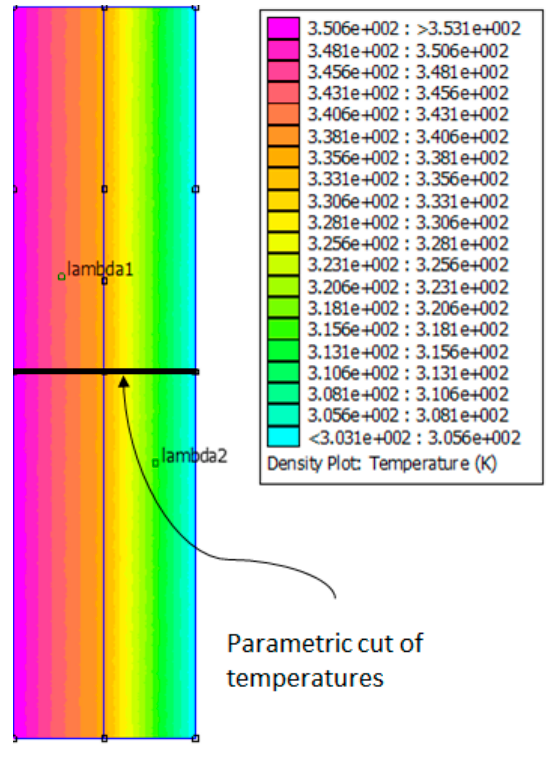
Figure 7. Temperatures of reference with FEMM and λ 1 = 50.0 Wm − 1 K − 1 and λ 2 = 193.0 Wm − 1 K − 1 .